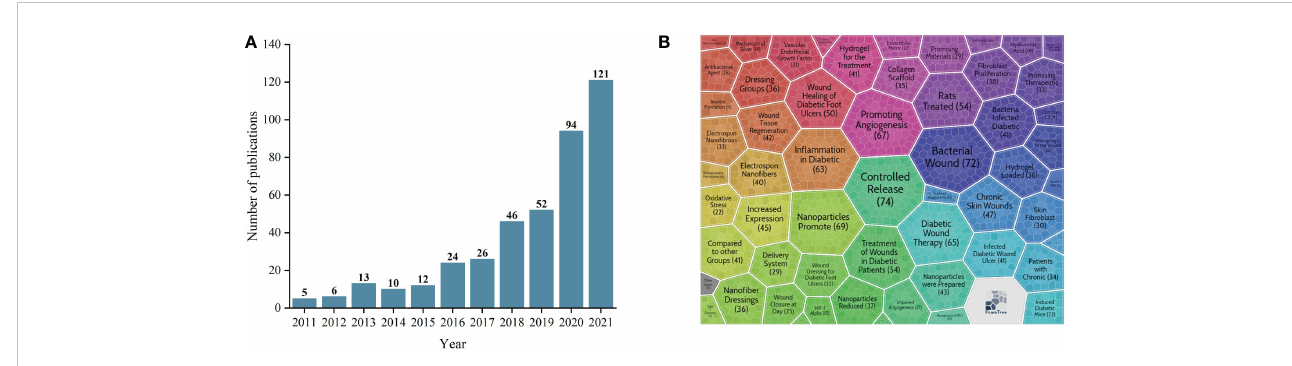
FIGURE 2 Annual number of publications (A) and theme clusters for the nanomaterials in diabetic non-healing wound by Carrot2 (B)